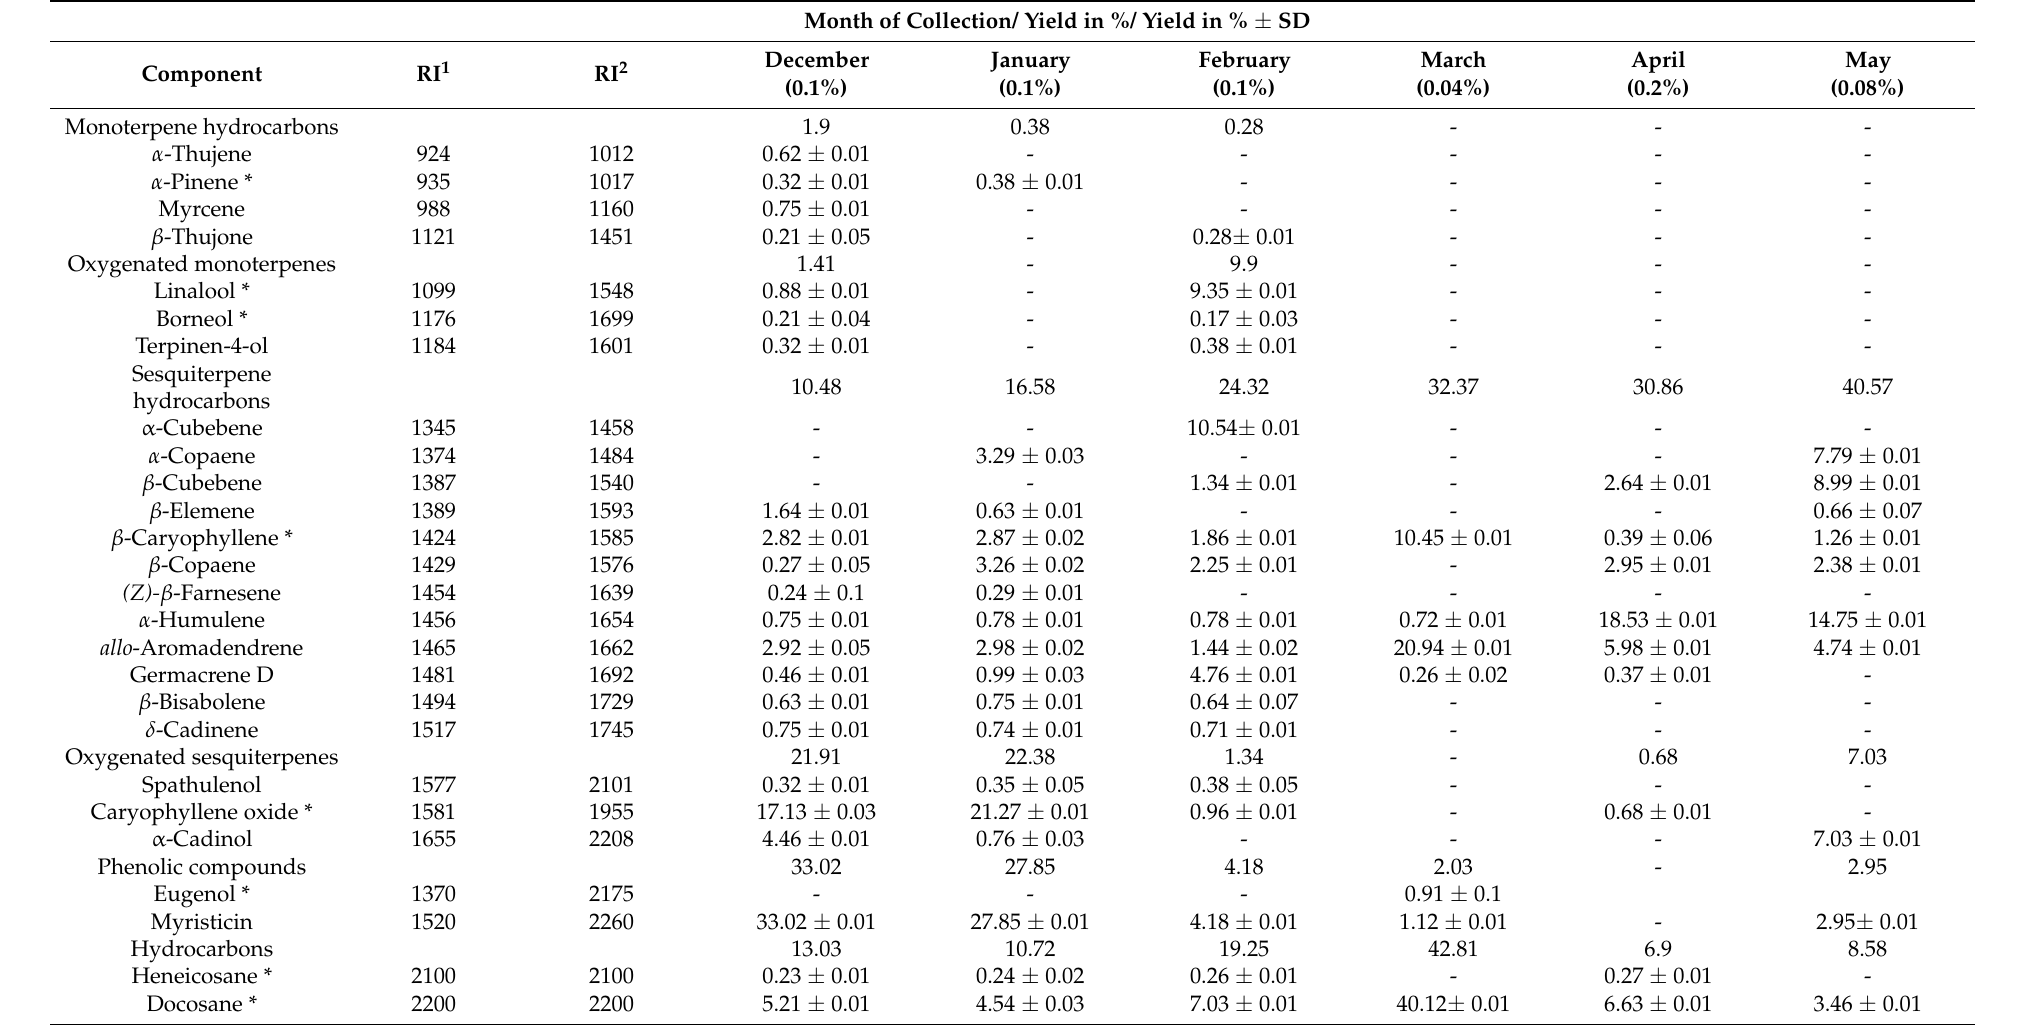
Table 2. Chemical composition of the essential oil of Olea europaea L. cv. Oblica from six